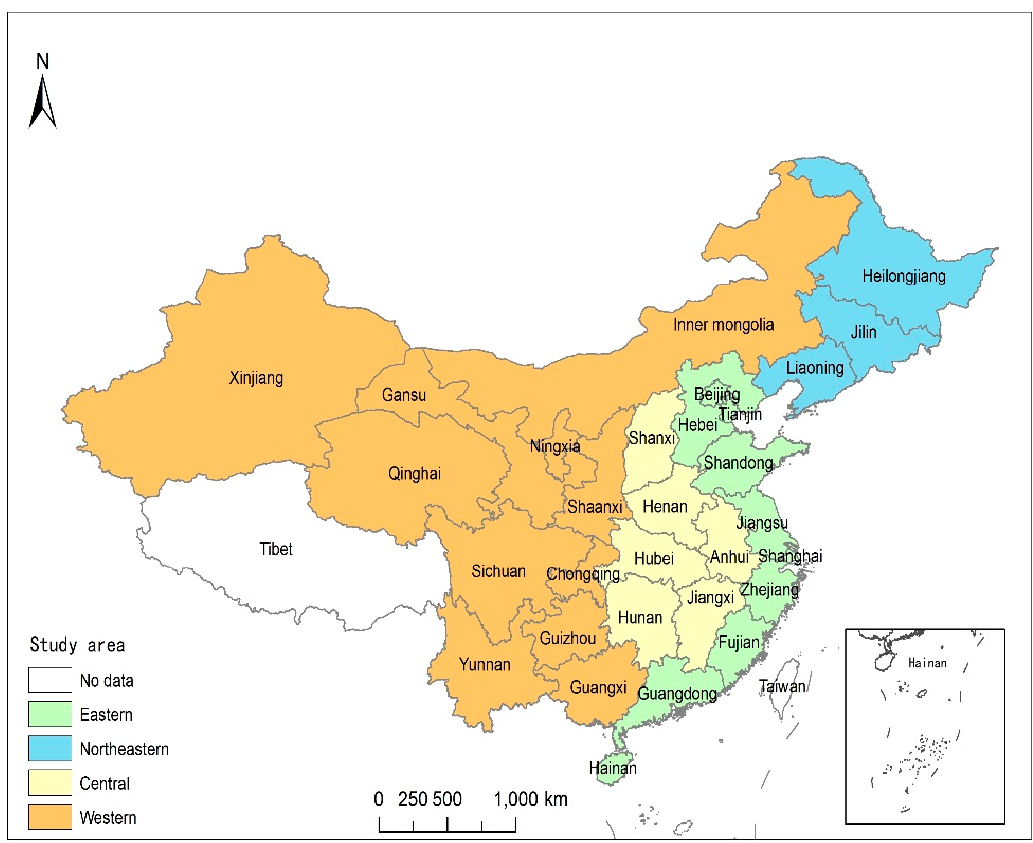
Figure 1. Study area.